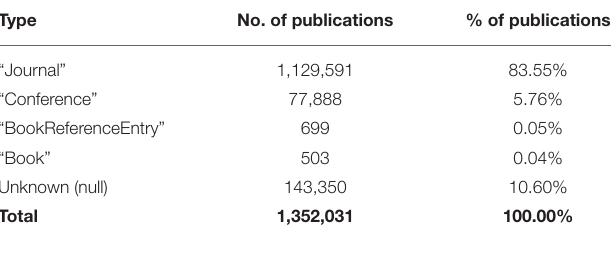
TABLE 2B | Summary of different document types in the subset of IRC publications used for calculating the infinity index in this